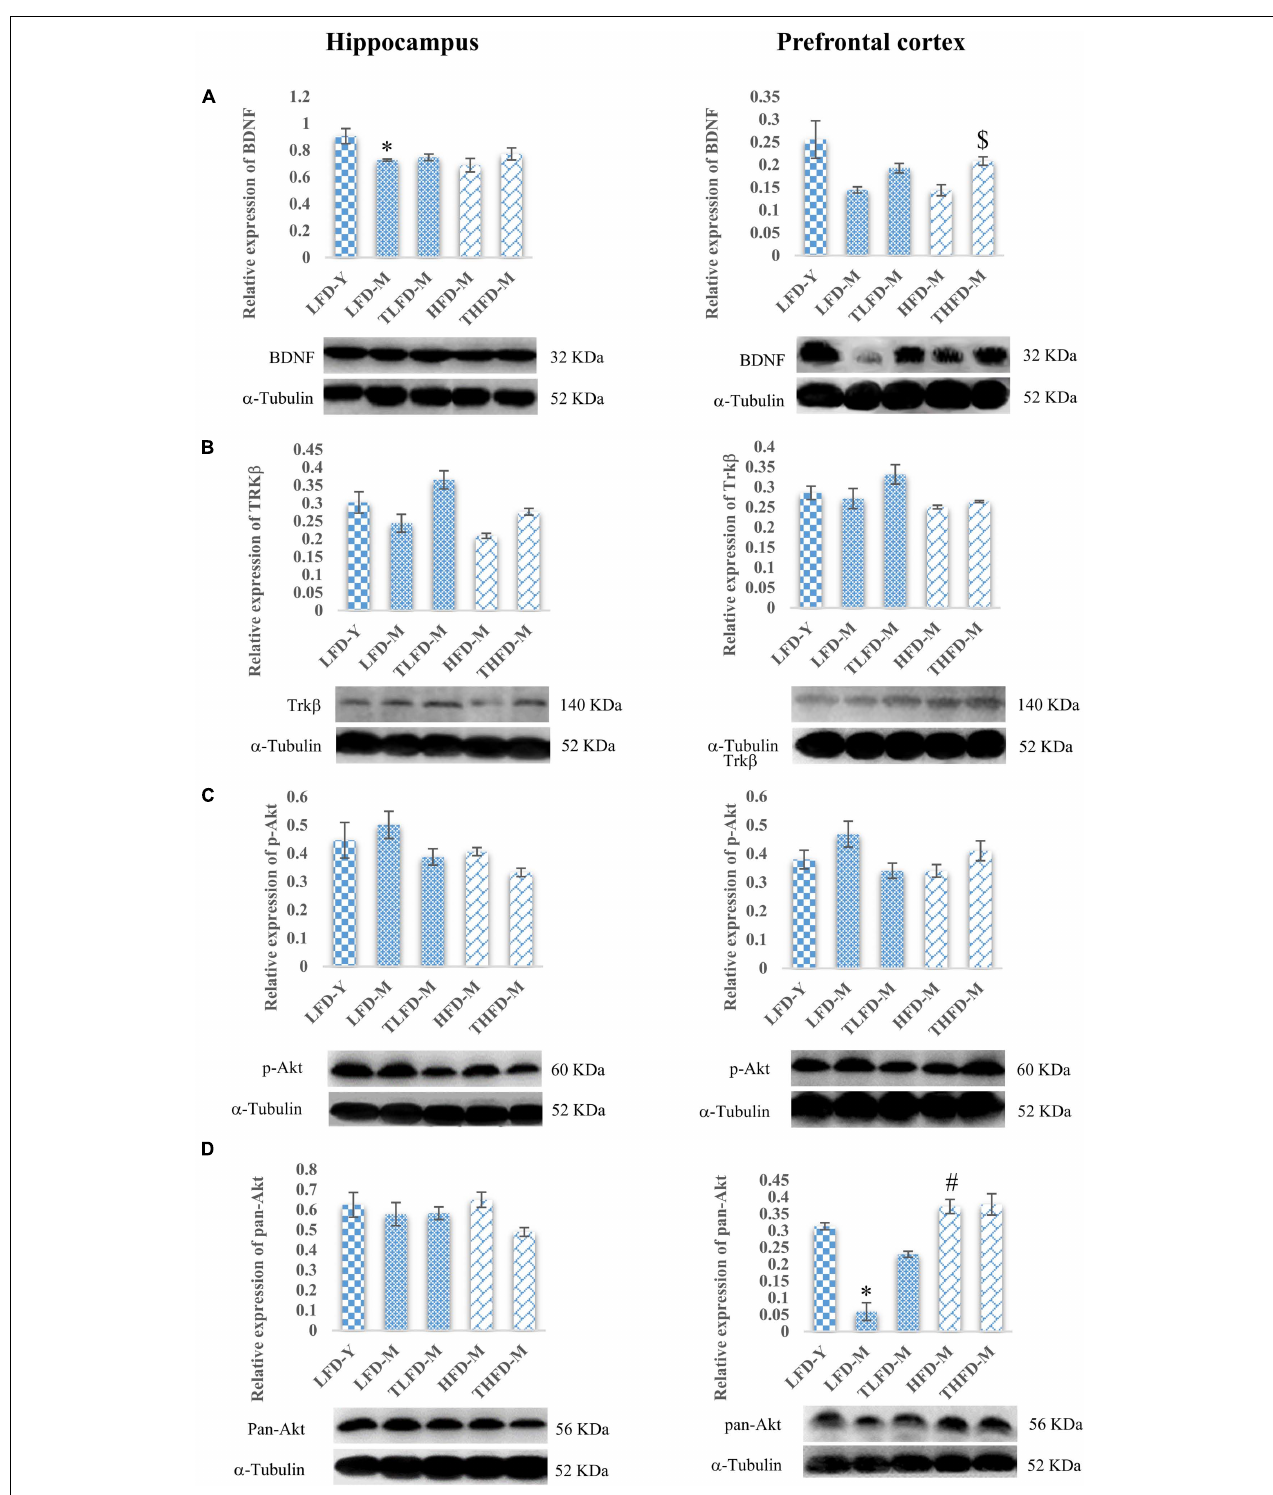
FIGURE 5 | Tinospora cordifolia stem powder (TCP) supplementation modulated the expression of target proteins associated with synaptic plasticity and cell survival BDNF/Trk β pathway in middle-aged acyclic female rats. Histogram representing analysis of fold change in the expression of (A) BDNF, (B) Trk β , (C) p-Akt, and (D) pan-Akt in the hippocampus (left panel) and the prefrontal cortex (PFC) (right panel) regions of the brain. Values are presented as mean ± SEM. ∗ p ≤ 0.05 LFD-Y vs. LFD-M; # p ≤ 0.05 LFD-M vs. HFD-M; $ p ≤ 0.05 HFD-M vs. THFD-M.